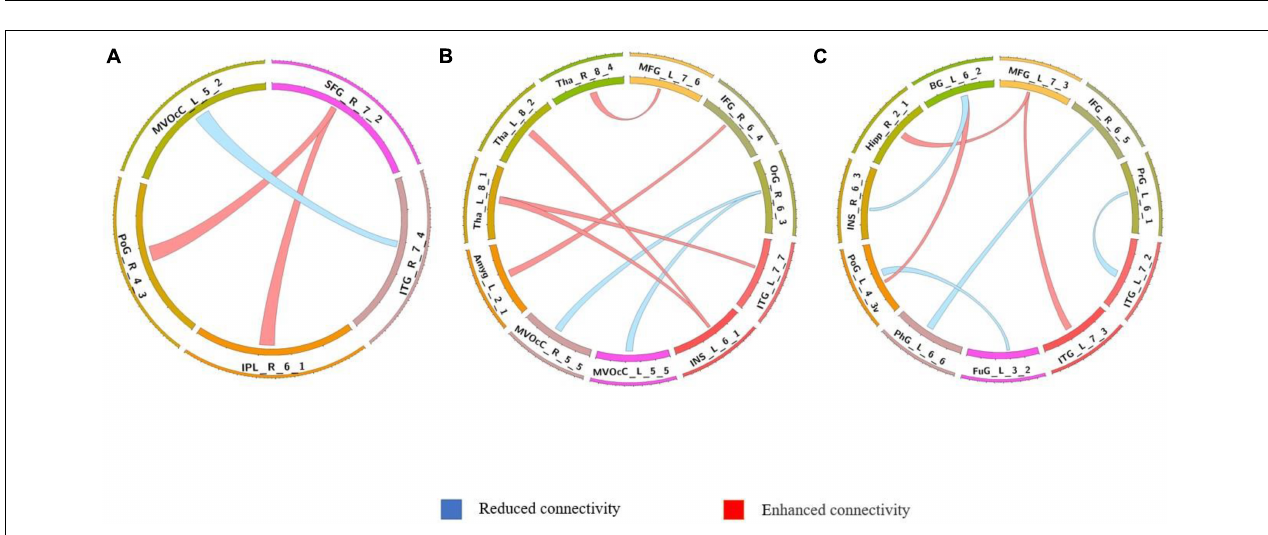
FIGURE 4 | Comparison of dynamic functional connectivity without global signal regression (overlap = 0.9). (A) AVHs group compared with the non-AVHs group; (B) AVHs group compared with the NC group; (C) non-AVHs group compared with the NC group. Increased connectivity was shown in red and decreased shown in